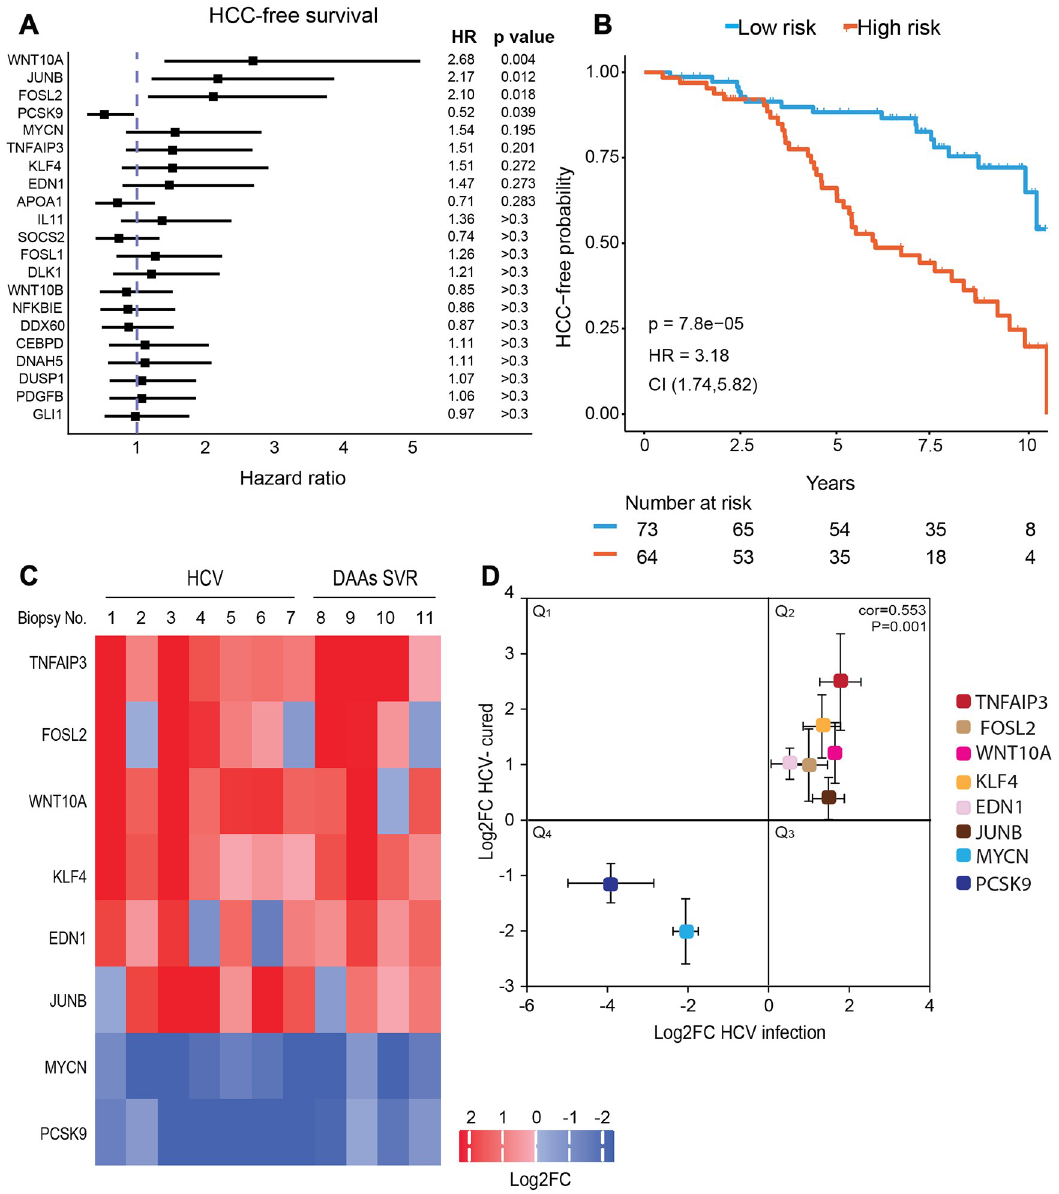
Fig 4. Epigenetic signature in human liver biopsies following cure of HCV infection. (A) Forest plot of hazard ratios (HR) for HCC development among hepatitis C-related early stage cirrhosis samples [30], stratified according to the median gene expression levels. P-values were calculated using log-rank test. Genes are ordered from lowest to highest p-values. The HR, 95% confidence intervals (CI) and p-values are shown. (B) HCC-free survival according to the level of expression of the 8-gene signature ( WNT10A , JUNB , FOSL2 , MYCN , TNFAIP3 , KLF4 , EDN1 , PCSK9 ). P-values were calculated using log-rank test. The HR and 95% CI are shown. (C and D) H3K9Ac ChIP was performed on liver biopsies (clinical data is described in S4 Table). The level of H3K9Ac for specific genes was quantified by qPCR, and values were normalized to ChIP with normal Rabbit IgG Ab only. These levels were quantified in 7 HCV-infected biopsies (No. 1–7) and 4 SVR biopsies (No. 8–11) and compared to the average level of the 6 control biopsies (No. 12–17). (C) Values of Log2FC for H3K9Ac ChIP-qPCR for each sample and each gene versus control are presented as a heatmap. (D) A scatter plot showing for each gene the Log2FC average values for H3K9Ac ChIP-qPCR for the HCV-infected biopsies (No. 1–7) versus the Log2FC H3K9Ac ChIP-qPCR average values for the SVR biopsies (No. 8–11). Correlation was calculated by Spearman rank (cor = 0.553, p = 0.001).